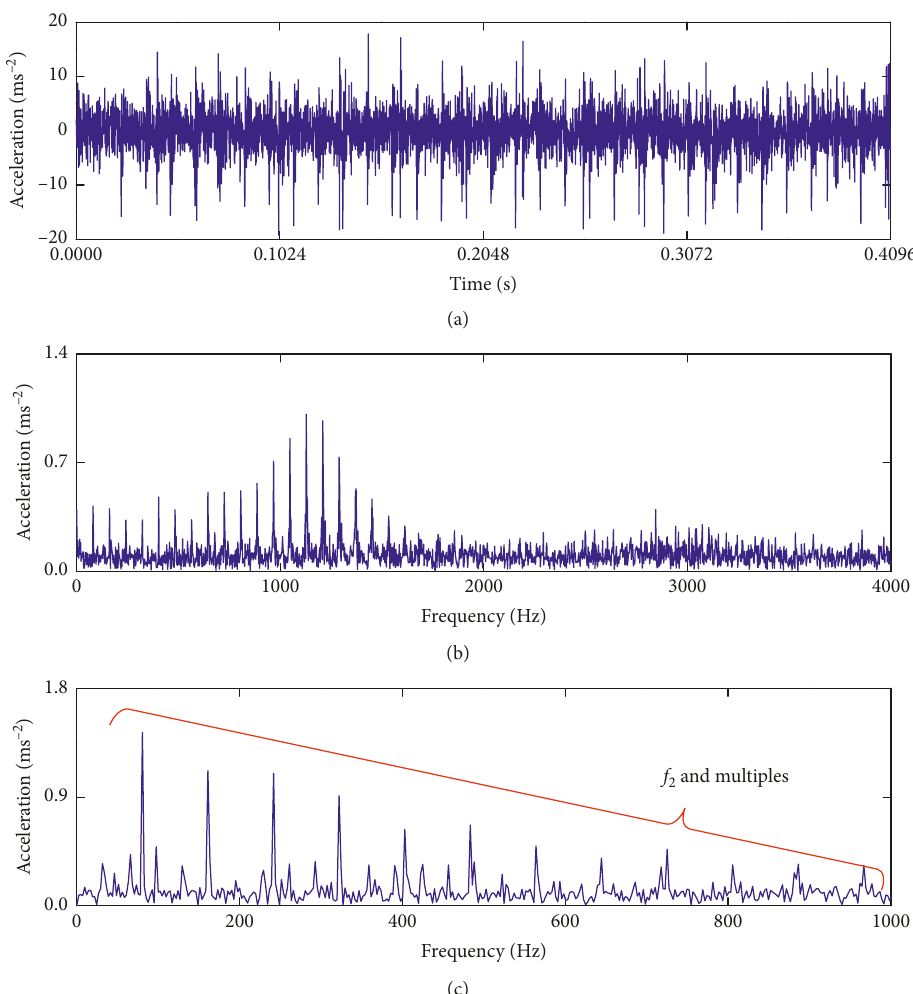
Figure 16: Simulated IRSs: (a) original signal; (b) its Fourier spectra; (c) its envelope